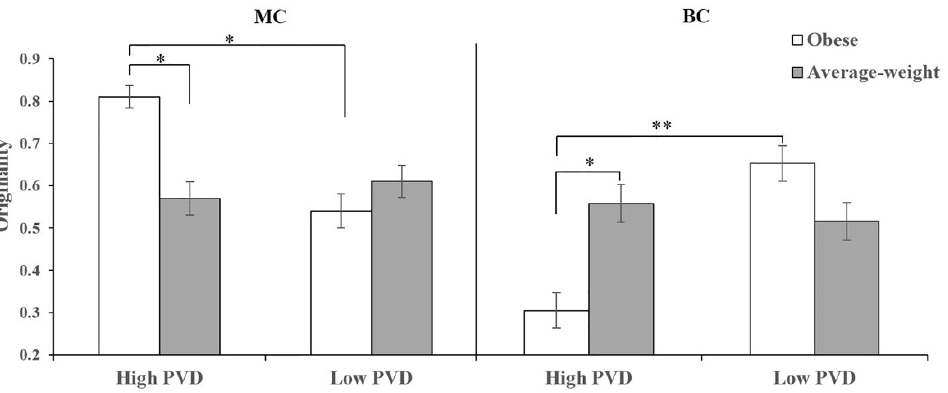
Figure 6. The influences of the interaction between PVD and disease-connoting cue on MC originality and BC originality (displayed ± SE ). * p < 0.05; ** p < 0.01. For the NC fluency and originality, we did not find any significant main effect ( ps ≥ 0.141) or interaction effect ( ps ≥ 0.525).